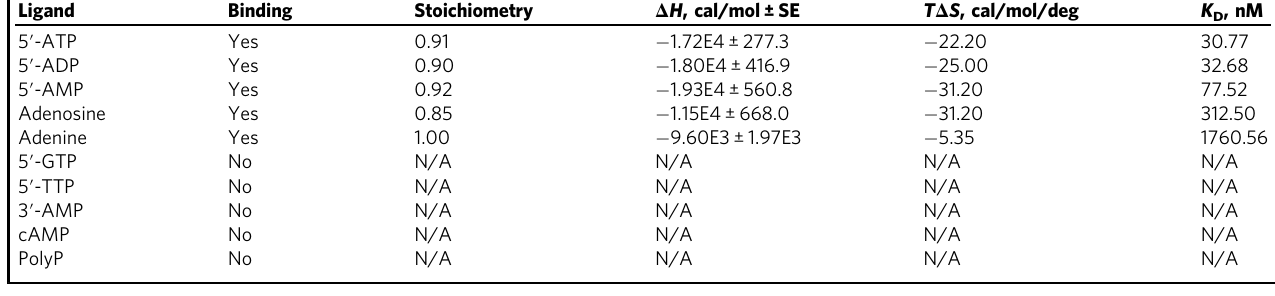
Table 1 Thermodynamic parameters of CxD7L1 protein by ITC. Ligand Binding Stoichiometry